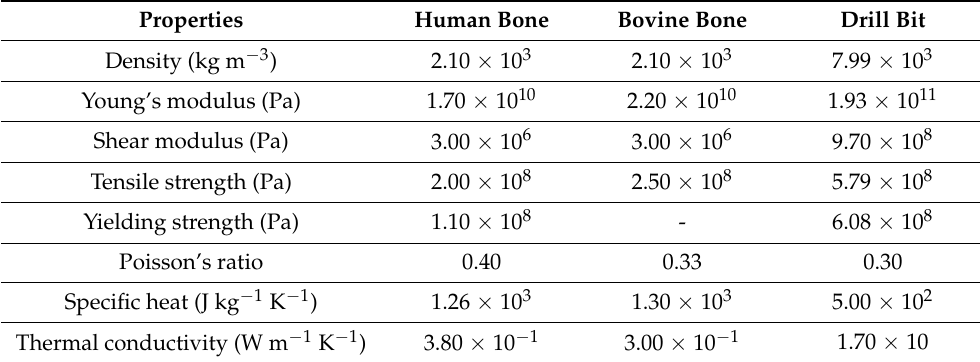
Table 1. Mechanical properties comparison of bovine bone and human bone properties [10].